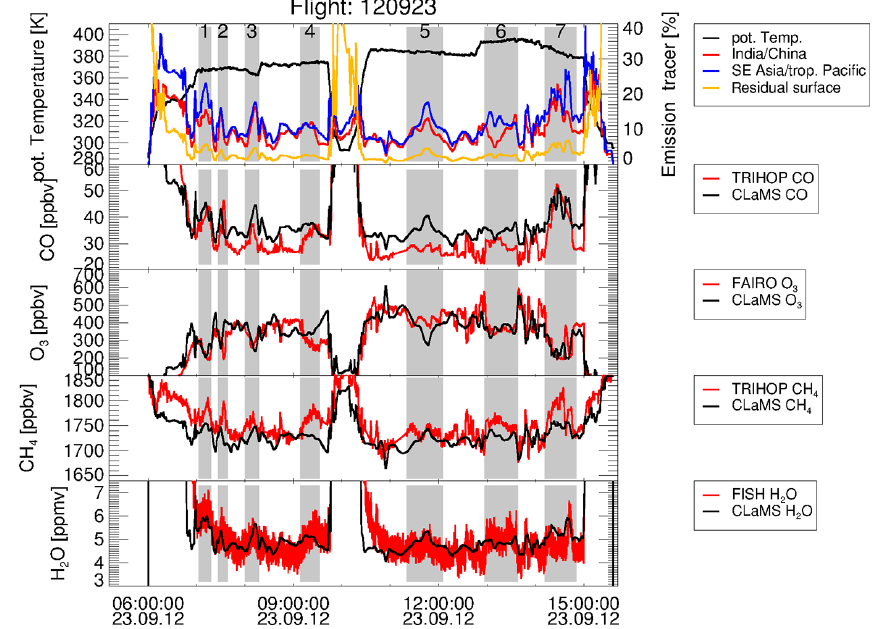
Figure 11. The same as Fig. 9, but for the flight on 23 September